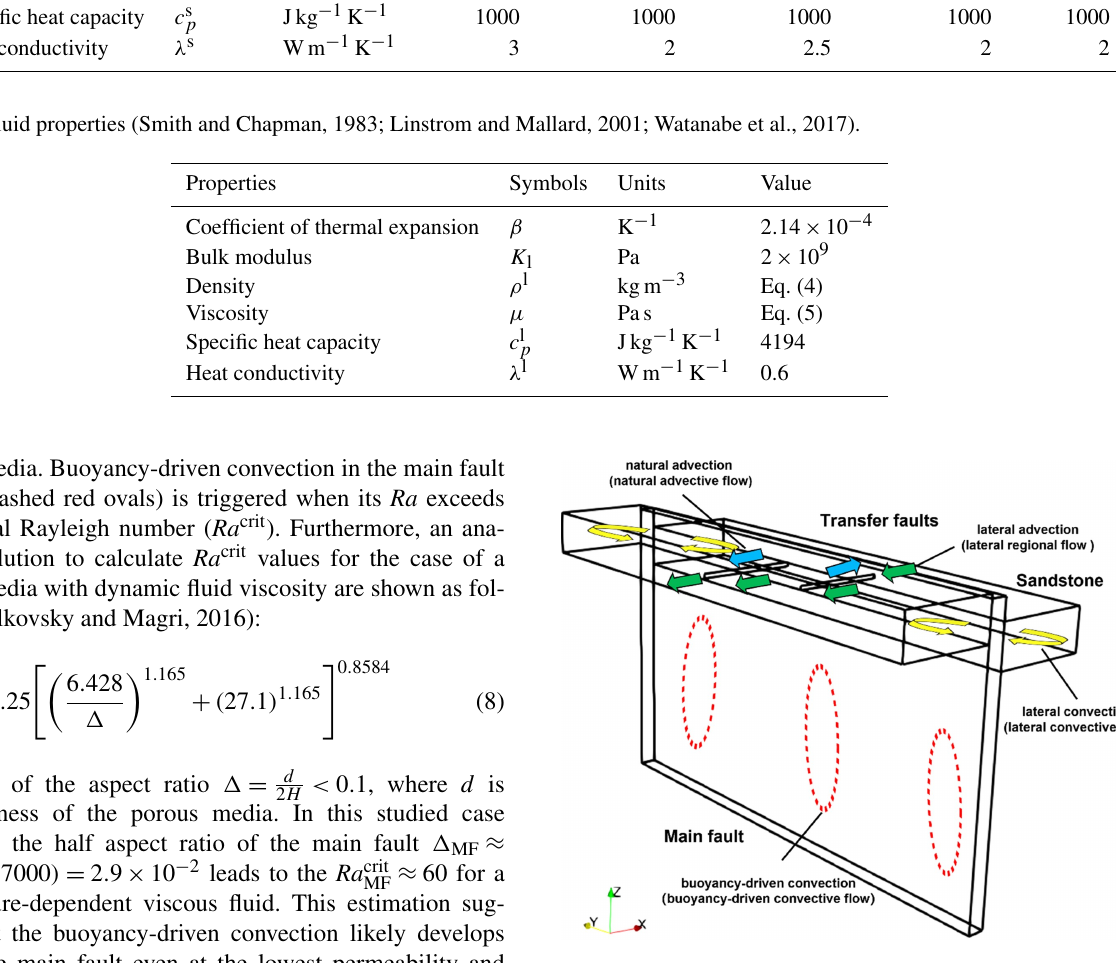
Table 1. Parameters of the lithological units (Bruns et al., 2013; Wüstefeld et al., 2017a; Becker et al., 2019; Busch et al., 2019). Properties Symbols Units Caprock Main fault Sandstone Transfer faults Basement Porosity n – 0.01 Bulk modulus Density